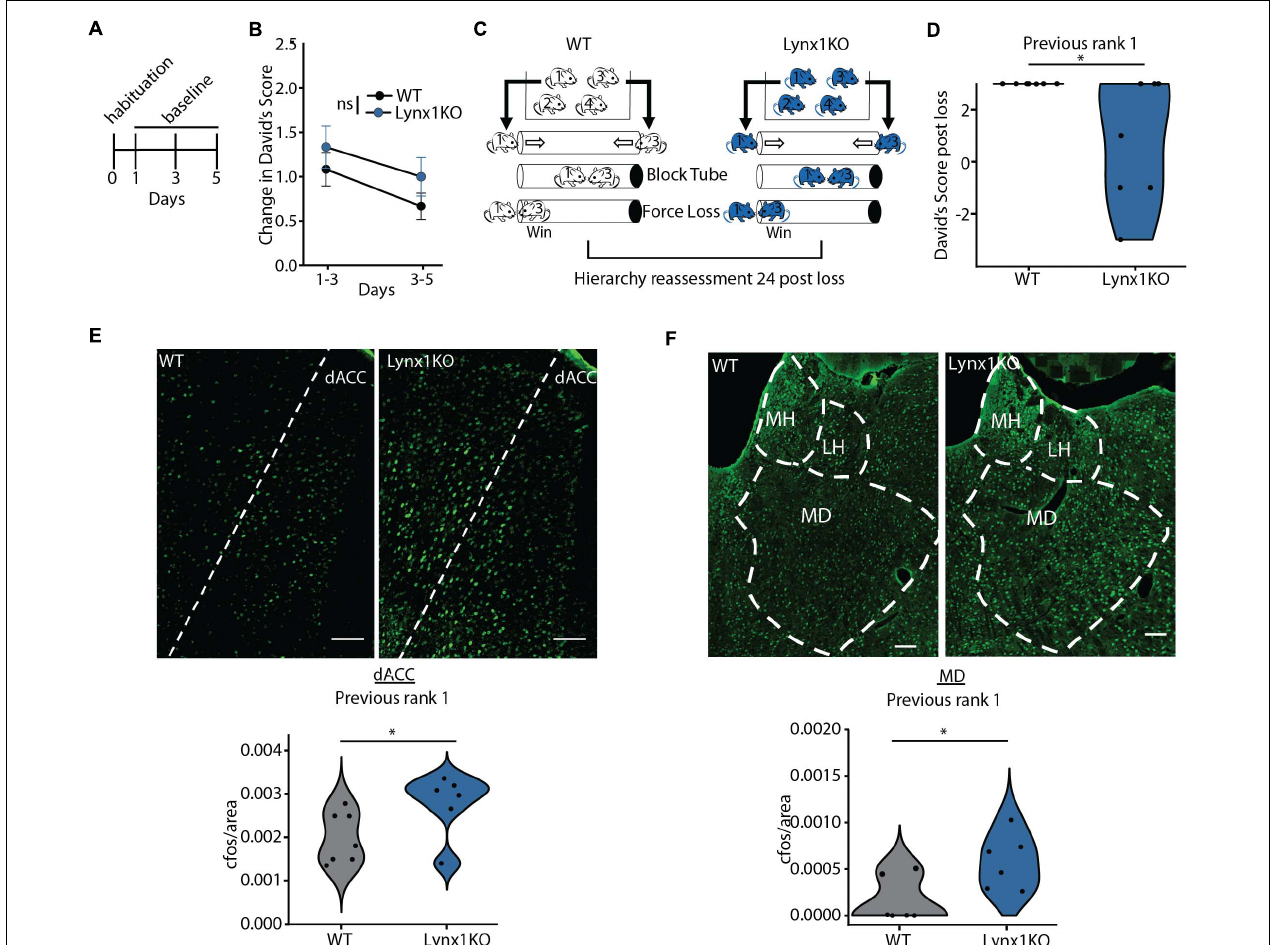
FIGURE 2 | Cortical plasticity modulator Lynx1 limits experience-dependent plasticity of social hierarchy in adult mice. (A) Adult WT or Lynx1KO mice were tested in a round-robin design to assess dominance between all pairs in a cage. Mice were habituated to the tube and then baseline hierarchy was assessed every other day for 5 days. Baseline day 1 was training. (B) Baseline hierarchies showed no significant differences in change in David’s Score (DS) between genotypes (generalized linear model, p = 0.323, n = 36 Lynx1KO from 9 cages, n = 48 WT from 12 cages). (C) Experience-dependent changes in hierarchy were assessed by altering the outcome of the rank 1 vs. 3 match-up by blocking the tube, forcing the rank 1 animals to lose. Hierarchies were reassessed 24 h later. (D) WT previous rank 1 mice maintained their rank following loss while Lynx1KO mice showed significantly reduced DS 24 h post loss (Wilcoxon signed rank test, ∗ p = 0.03, n = 7 WT mice, 7 Lynx1KO mice). (E) Dorsal Anterior Cingulate (dACC) shows significantly increased c-Fos labeling in adult Lynx1KO mice following forced loss (two-tailed un-paired student’s t -test, ∗ p = 0.05, n = 7 WT mice, n = 6 Lynx1KO mice). (F) Mediodorsal thalamus (MD) shows significantly increased c-Fos in adult Lynx1KO